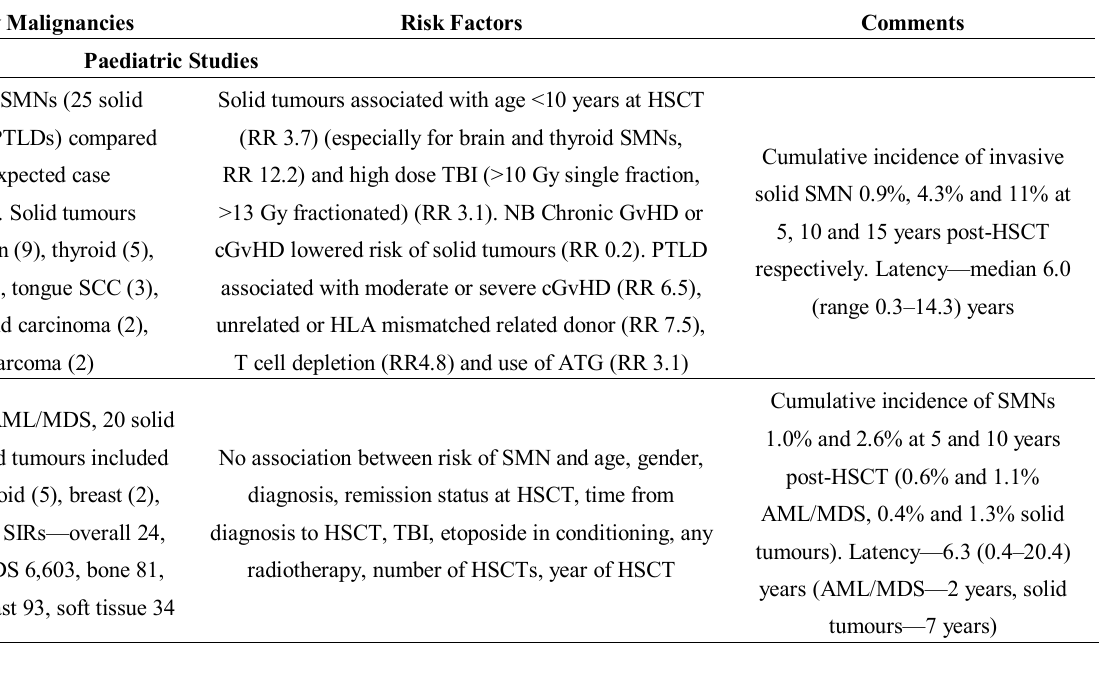
Table 2. Secondary malignancies following haematopoietic stem cell transplantation (HSCT) performed in